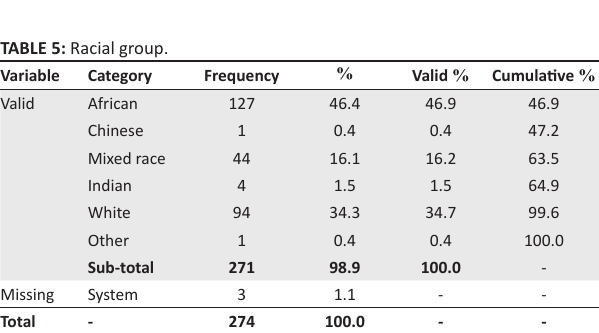
TABLE 4: Gender of respondents.